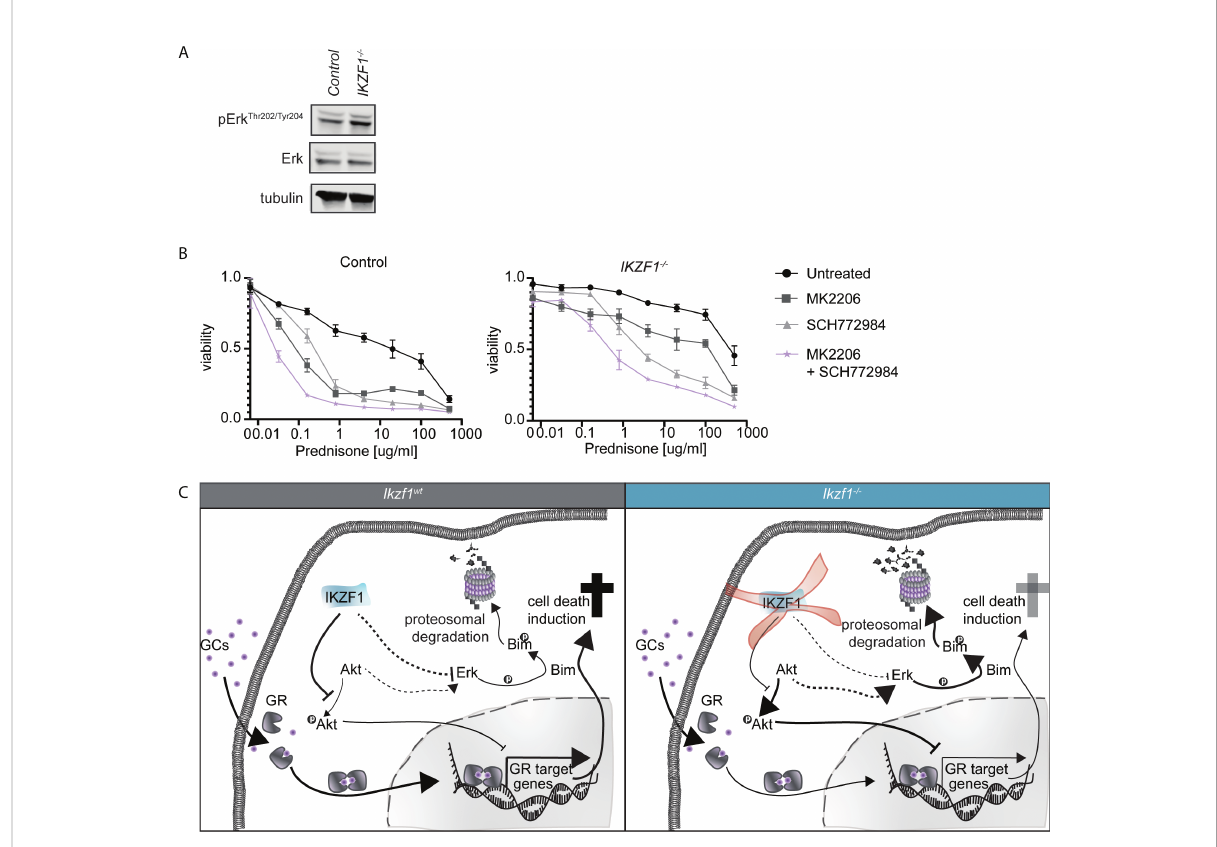
FIGURE 2 (A) Immunoblot analysis of protein expression in IKZF1 wildtype and de fi cient SEM cells. Phospho-ERK expression was quanti fi ed, normalized to total ERK expression and tested for differences using a student ’ s t-test (Supplemental Figure 4). (B) Cell death as determined by quanti fi cation of cells positive for amine-reactive dyes using fl ow cytometry in SEM wt and SEM IKZF1 -/- cells after a 4-day treatment with increasing concentrations of prednisolone in the presence or absence of 1 m M MK2206, SCH772984 or their combination. Each data point represents a mean (± SEM) of 3 independent experiments. The area under the curve (AUC) was determined and differences were tested for signi fi cance using an ANOVA followed by Tukey ’ s multiple comparisons test. p-values of the comparisons are listed in Supplemental Table 6. (C) Schematic representation of working model explaining how loss of IKZF1 might induce prednisolone resistance. In IKZF1 wt cells, IKZF1 represses AKT activity. Upon loss of IKZF1 , AKT activity is no longer suppressed. This results in repression of GR target gene activation upon prednisolone treatment. At the same time, ERK is activated either via crosstalk with AKT signaling or directly via IKZF1 which, in turn, can phosphorylate Bim inducing proteasomal